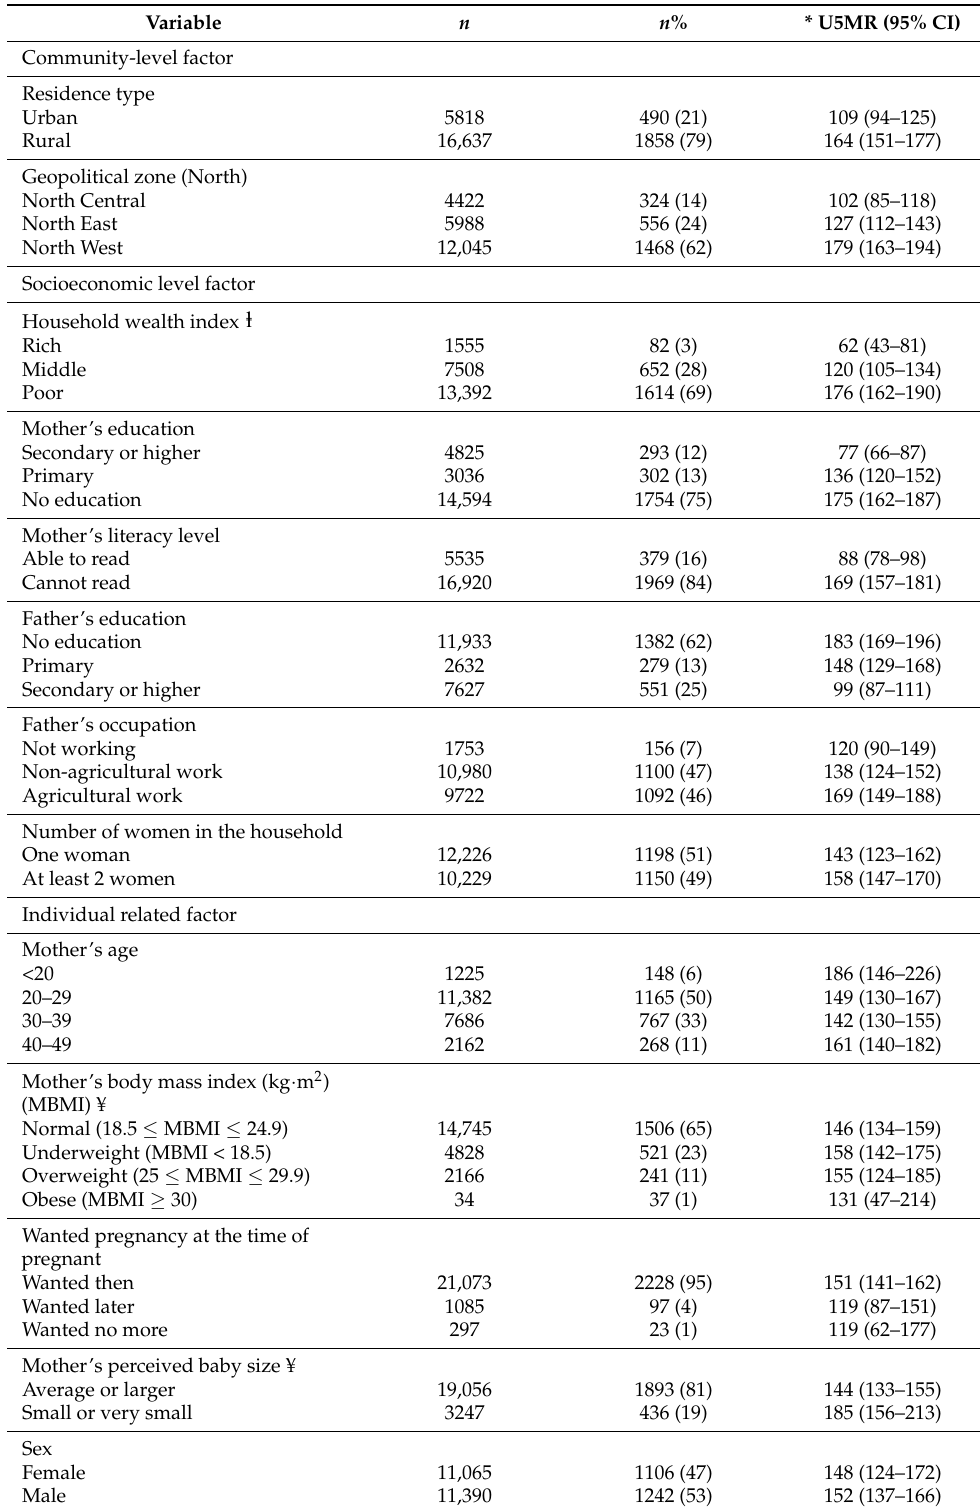
Table 2. Under-5 mortality rate, and distribution of characteristics reported in the 2018 NDHS, in three combined Northern geopolitical zones, Nigeria.